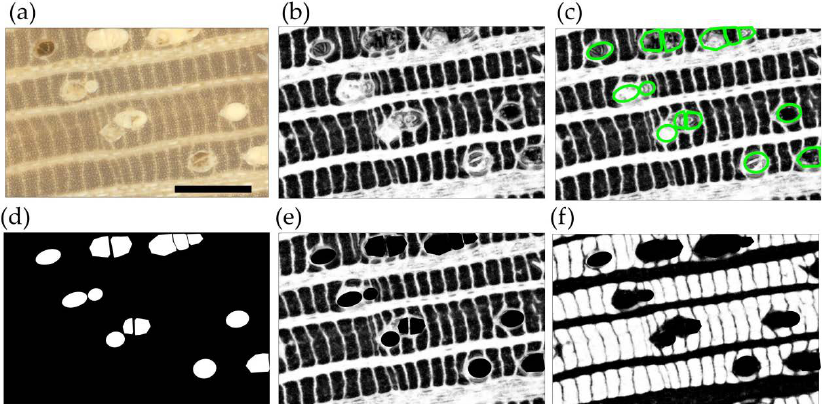
Figure 2. Flowchart for delineating vessels and parenchyma on a segment of a sanded surface of Polyalthia suaveolens with the trainable Weka plugin. The plugin assesses the probability for different portions of the image to be classified as vessel or parenchyma before being manually corrected. ( a ) Original sanded surface is imaged, ( b ) probability map for parenchyma with mismatches for vessel lumina, ( c ) correction through manual indication of vessels to become binary images of ( d ) vessel lumina and ( e ) parenchyma fractions. ( f ) Fibre fraction, as the subtract of the total image with vessel and parenchyma fraction. Scale 500 µ